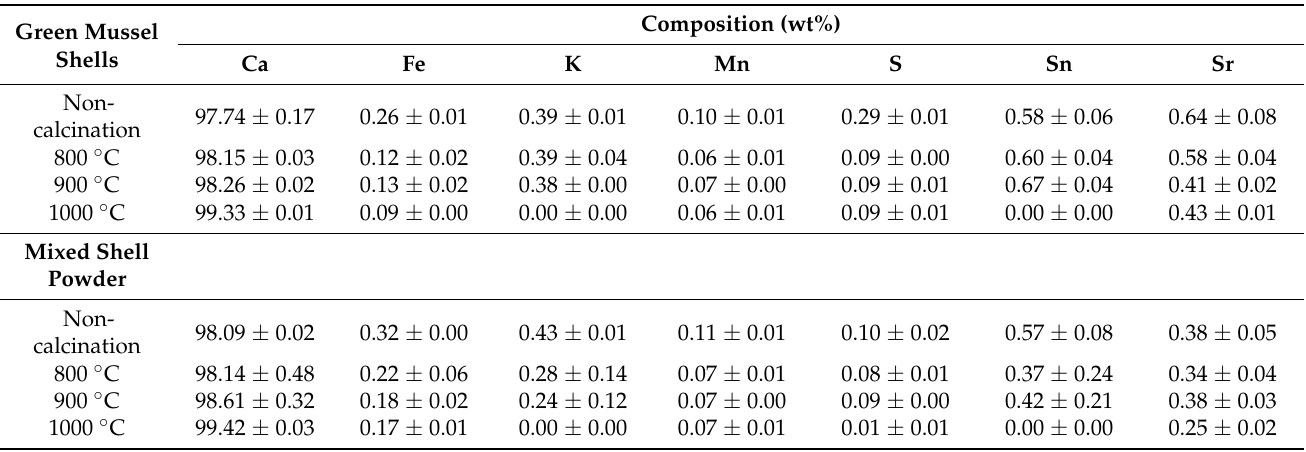
Figure 5. The FTIR spectra of ( a ) green mussel shells (3 h calcination) and ( b ) mixed shell powder (2 h calcination). Table 1. The Composition of Elements in Green Mussel Shells and Mixed Shell